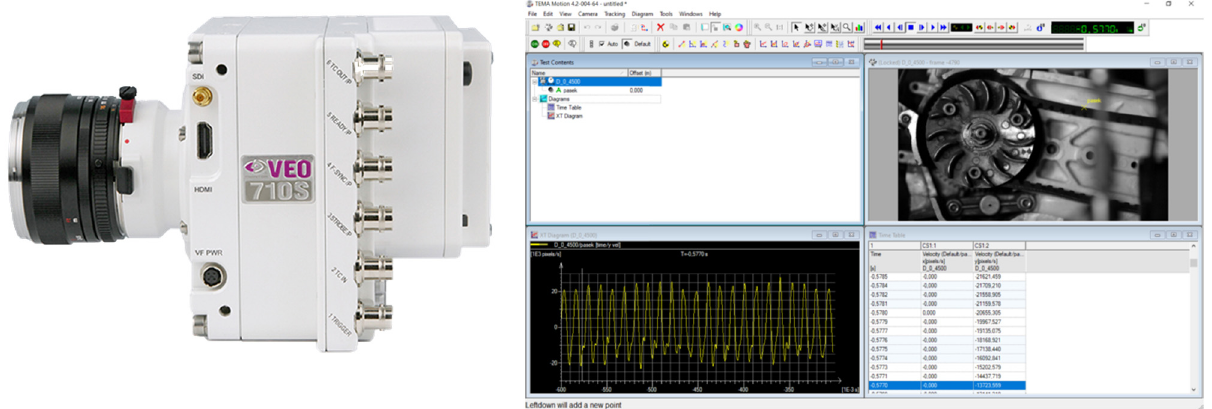
Figure 3: High - speed camera Phantom VEO 710S and view of TEMA Motion software